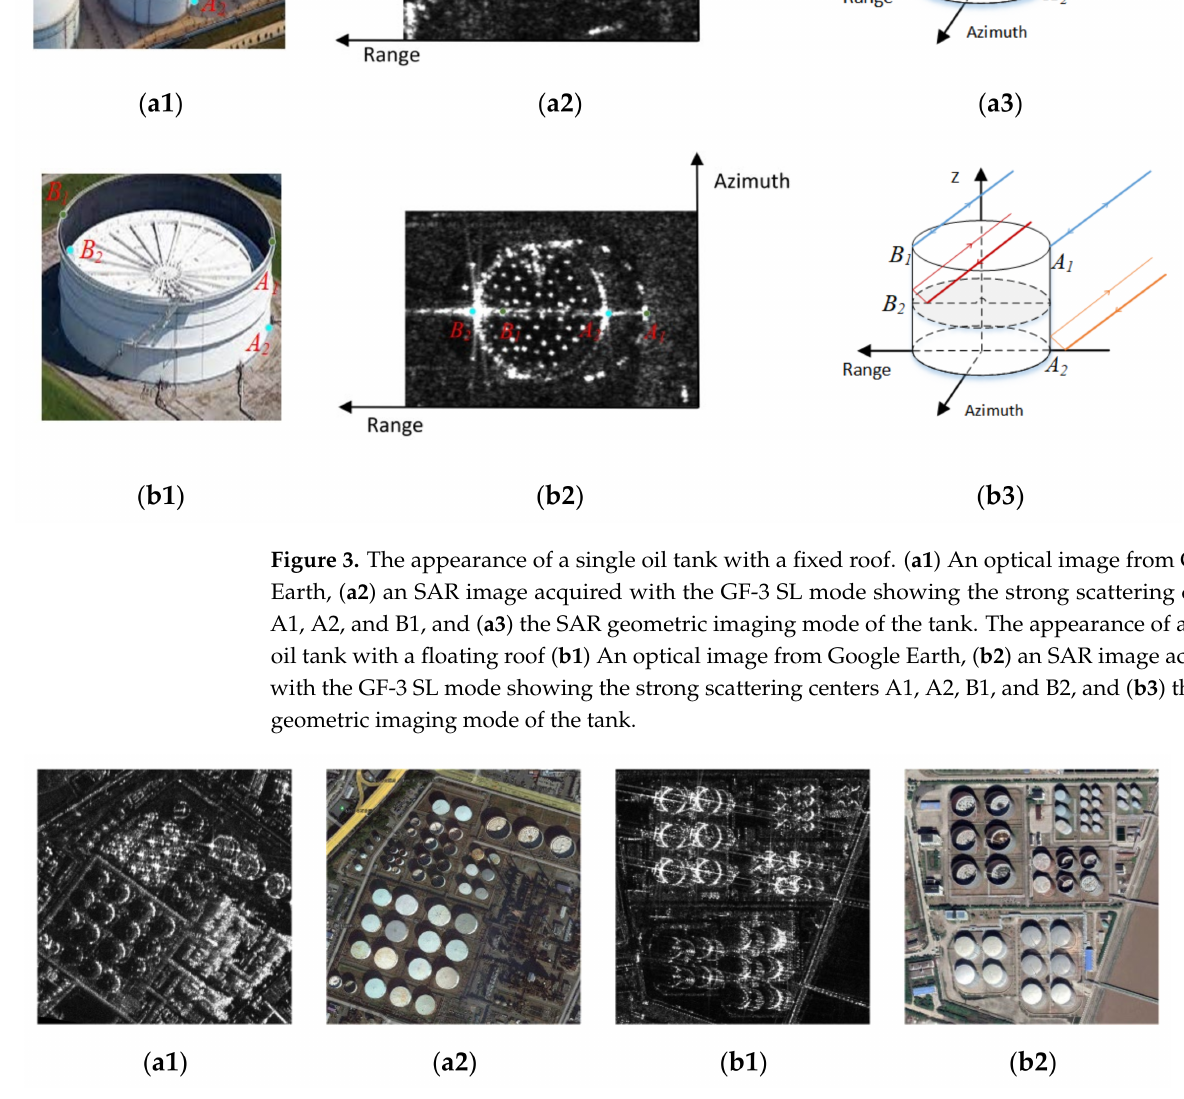
Figure 4. The appearance of oil tank slices of the OTD in densely distributed areas. ( a1 , b1 ) The SAR images acquired with the GF-3 SL imaging mode and ( a2 , b2 ) the optical images from Google